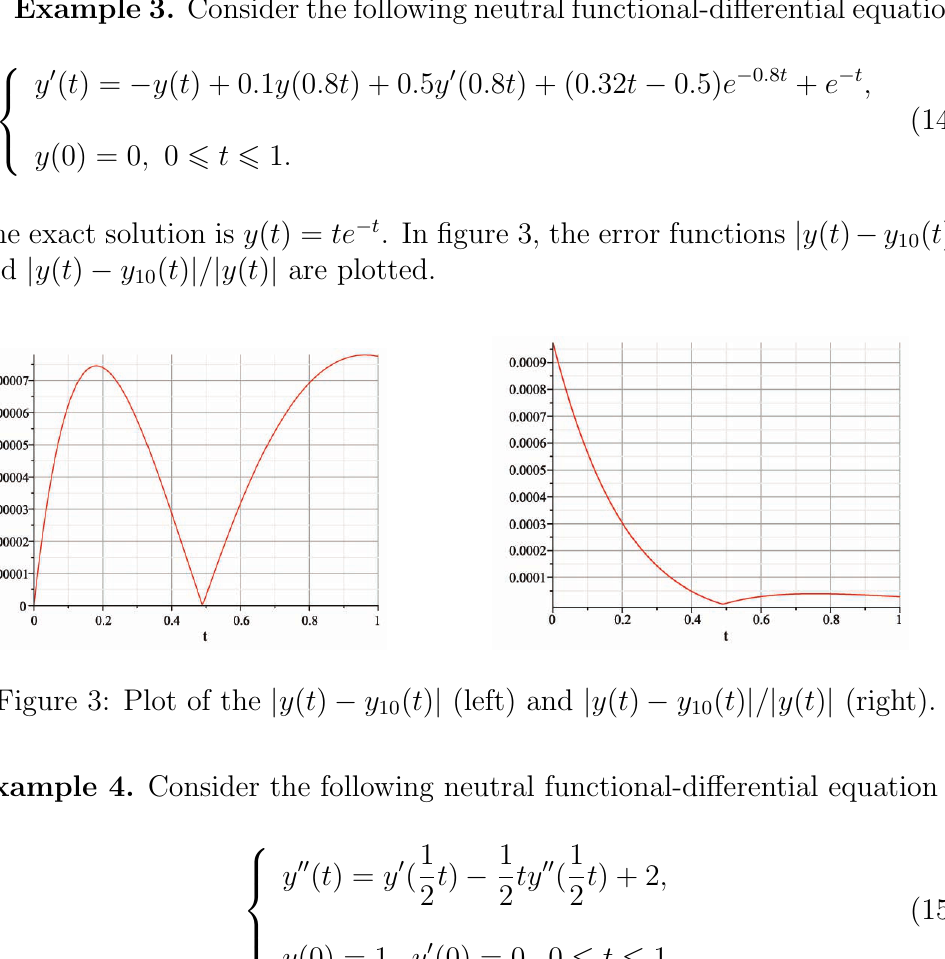
( t ) | (left) and | y ( t ) − y 10